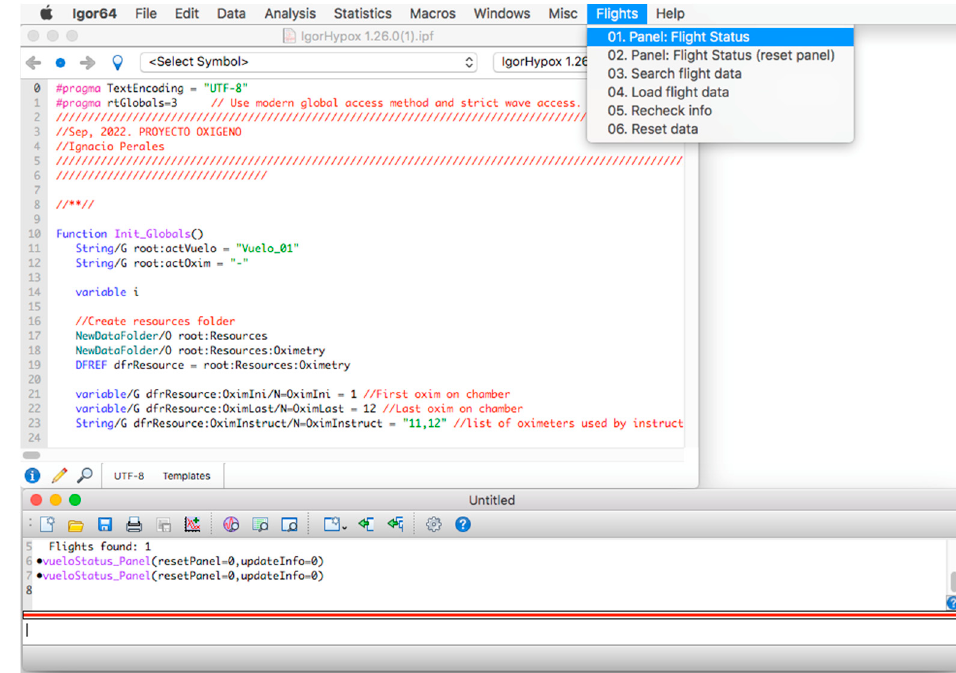
Figure 2. Initial screen of the procedure.